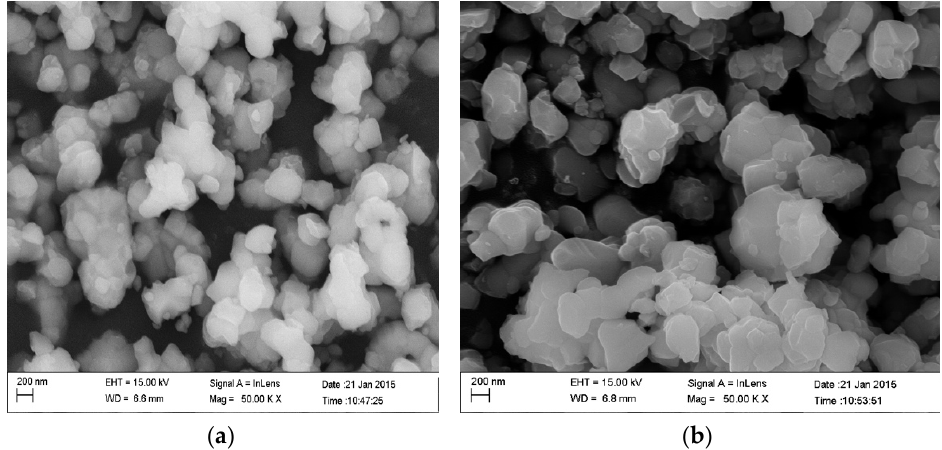
Figure 9. SEM images of hydrolyzing product at different temperatures: ( a ) 80 °C, 180 min and ( b ) 100 °C, 180 min.